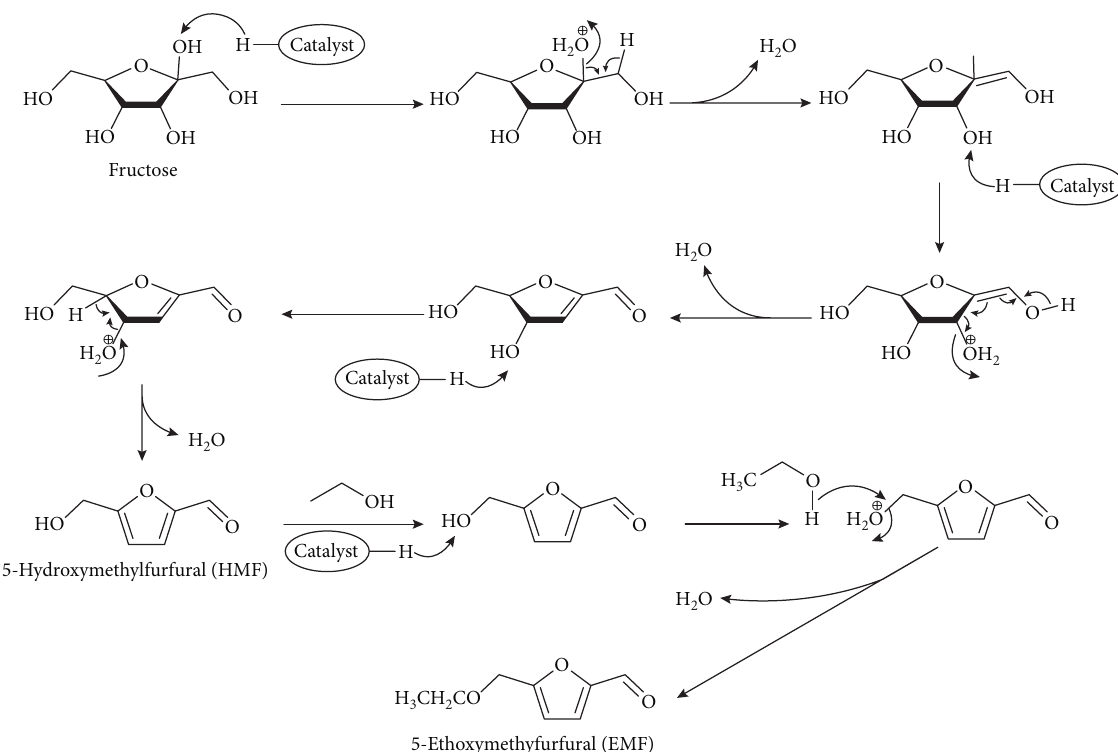
Scheme 1: The reaction mechanism involved in the conversion of fructose to